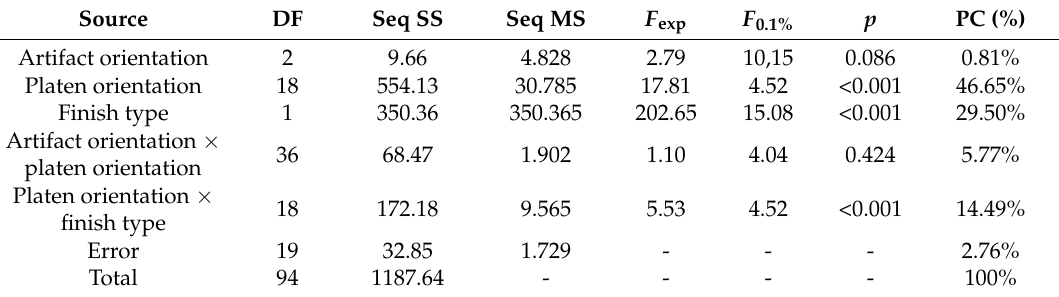
Table 8. The percentage contribution ratio based on generalized linear model (GLM).